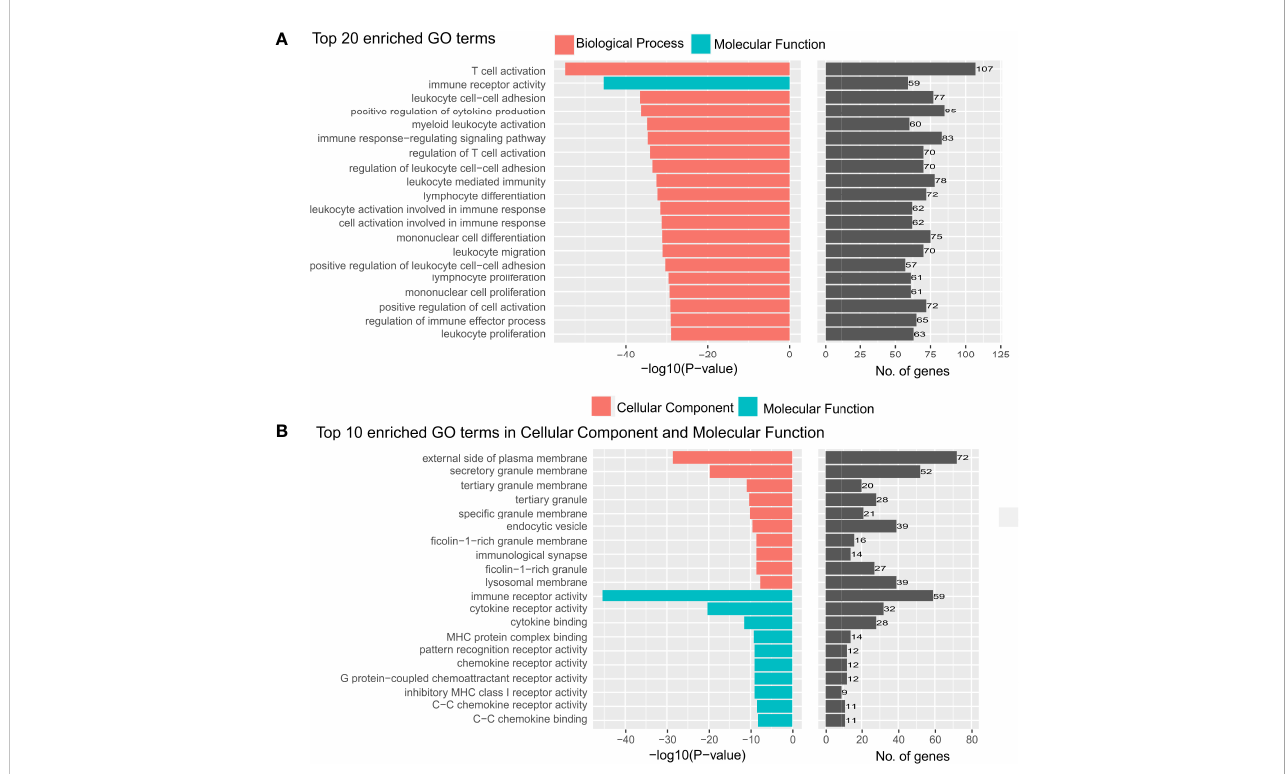
FIGURE 5 Top 20 gene ontology terms in the enrichment analysis. (A) The top 20 gene ontology (GO) terms that were signi fi cantly enriched in the enrichment analysis on genes that are related to the prognostically signi fi cant features in the model with tumor segmentation. (B) The top 20 GO terms which were signi fi cantly enriched in “ cellular component ” and “ molecular function ”